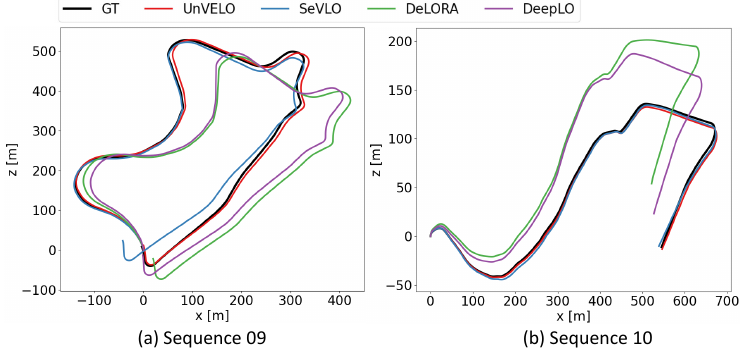
Figure 6. Trajectories of sequences 09 and 10 on KITTI.